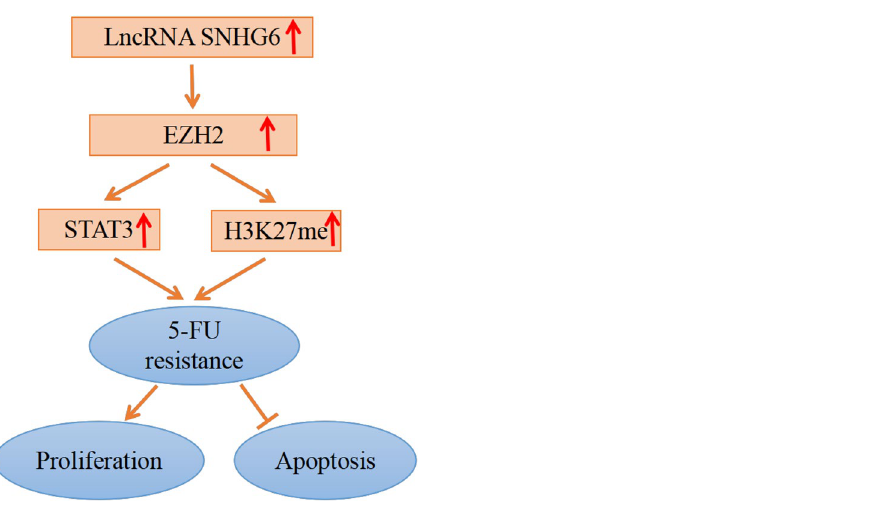
Figure 8. Schematic illustration of SNHG6/EZH2/STAT3 axis in regulating 5-FU resistance in